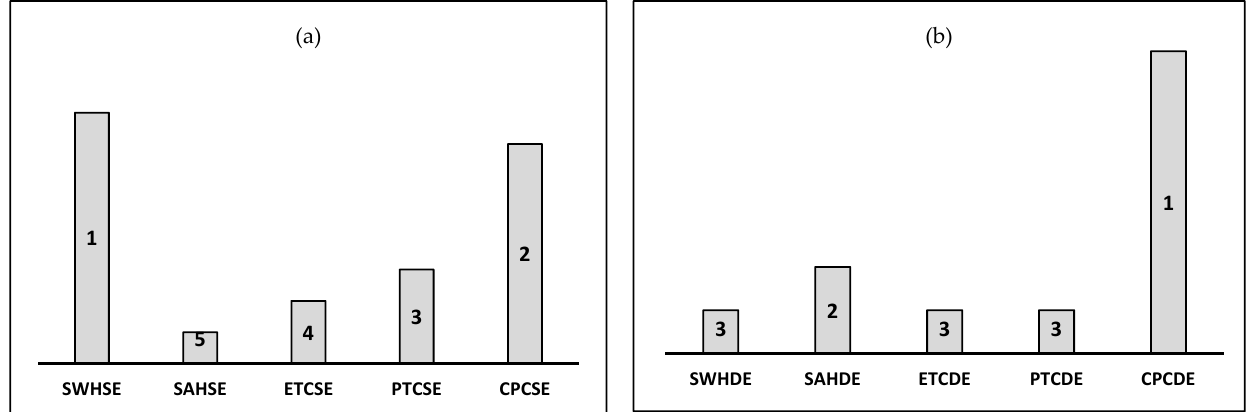
Figure 6. ( a ) Overall Ranking for Bsh climate zone SE, ( b ) Overall Ranking for Bsh climate zone DE.